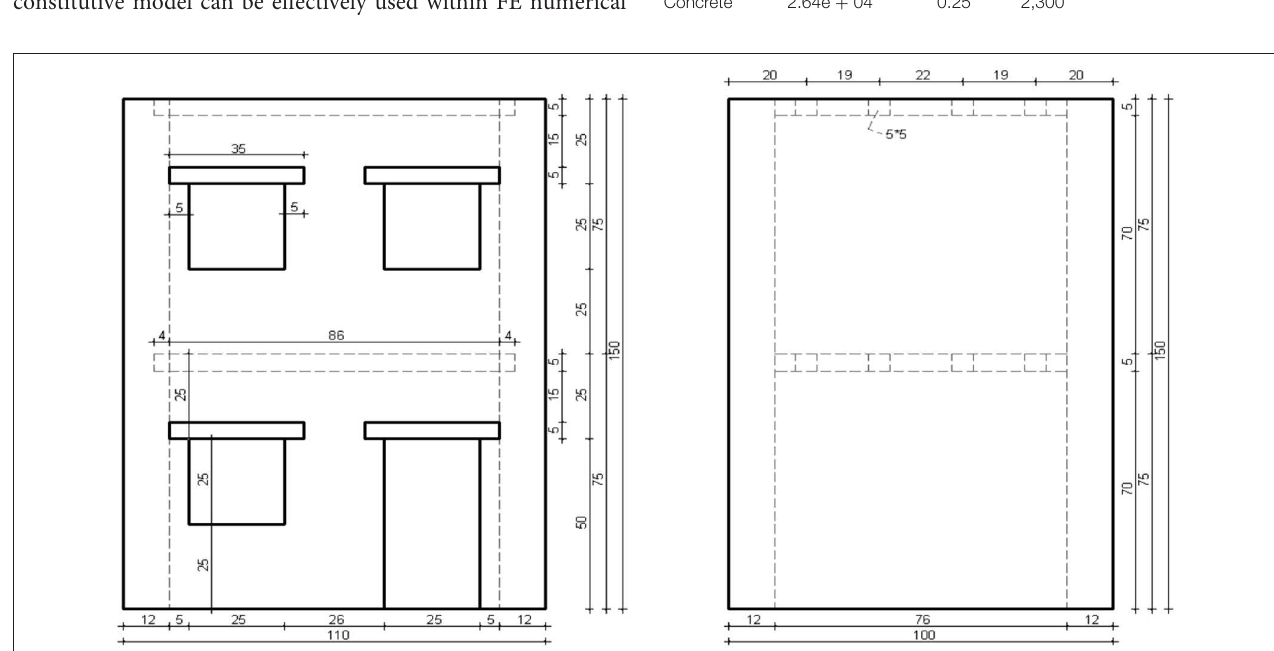
Frontiers in Built Environment |